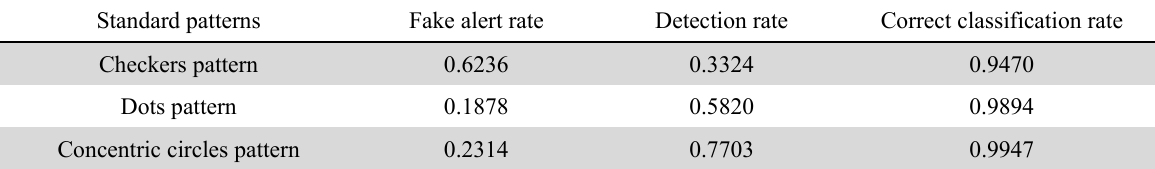
Performance indices of imaging distortion inspection by the Lin and Lo method and the proposed method using three common standard